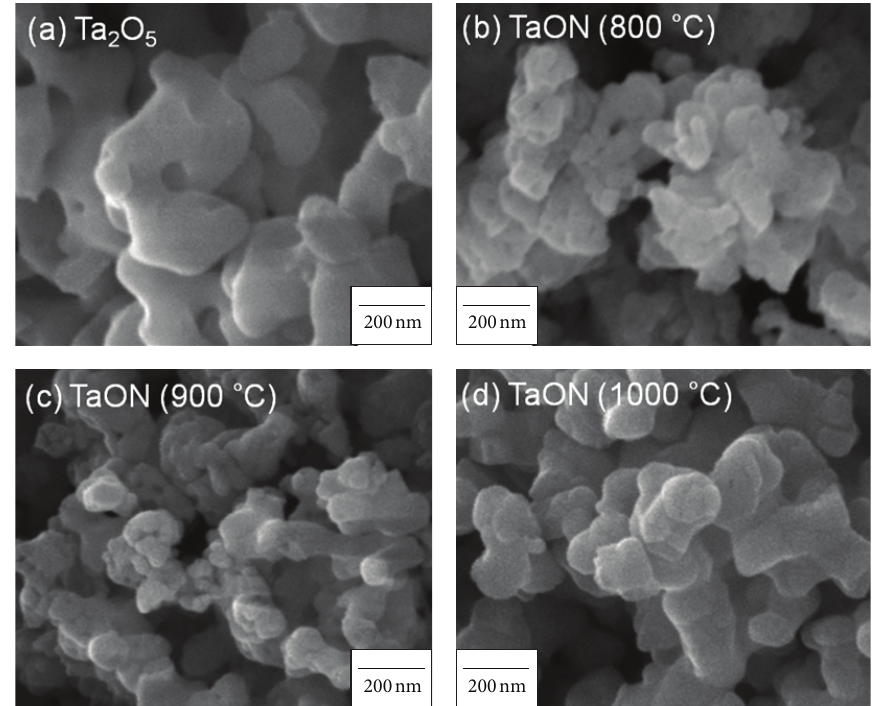
Figure 3: Scanning electron micrographs (SEMs) of the precursor Ta 2 O 5 and 𝛽 -TaON powders synthesized at 800 ∘ C, 900 ∘ C, and 1000 ∘ C,